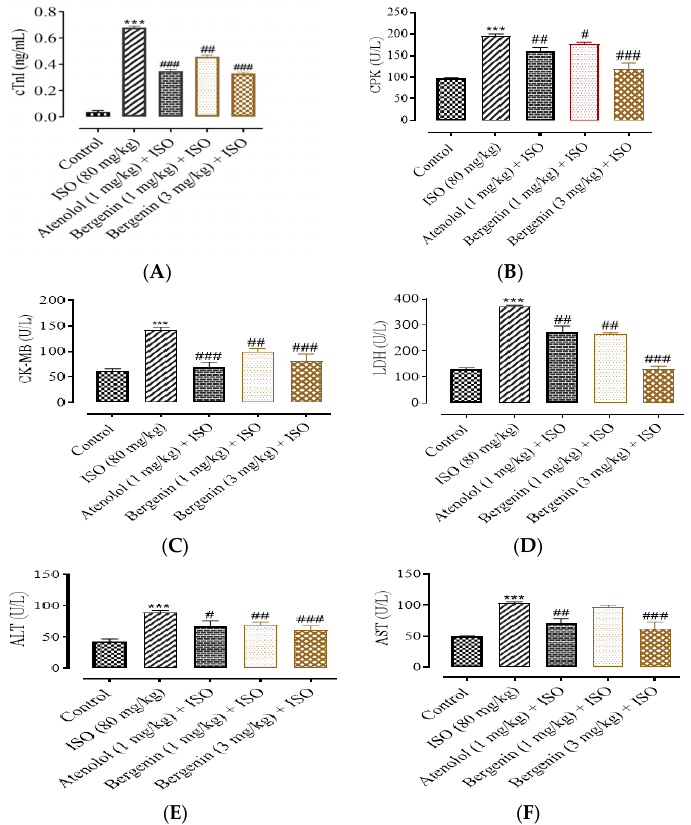
Figure 4. Bar graph ( A ) shows the response of bergenin and atenolol on serum level of cTnI (cardiac troponin I), ( B ) CPK (creatine phosphokinase), ( C ) CK-MB (creatine kinase-MB), ( D ) LDH (lactate dehydrogenase), ( E ) ALT (alanine transaminase), and ( F ) AST (aspartate transaminase) in isoproterenol-induced infarcted rats. Data are presented as mean ± SEM ( n = 6), where #, ##, ### indicates < 0.01 and 0.001 p values vs. ISO, respectively, and *** describes p value < 0.001 vs. Control.